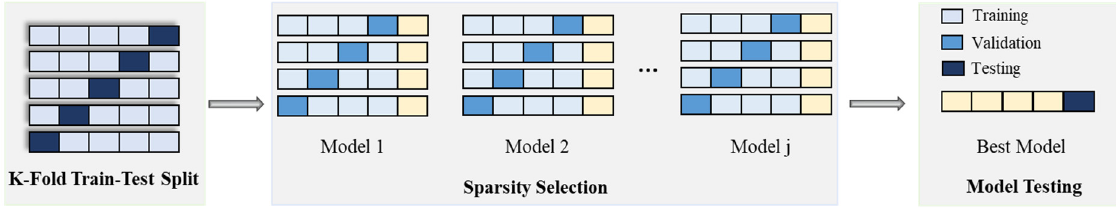
Figure 6. K-fold cross-validation algorithm [61].